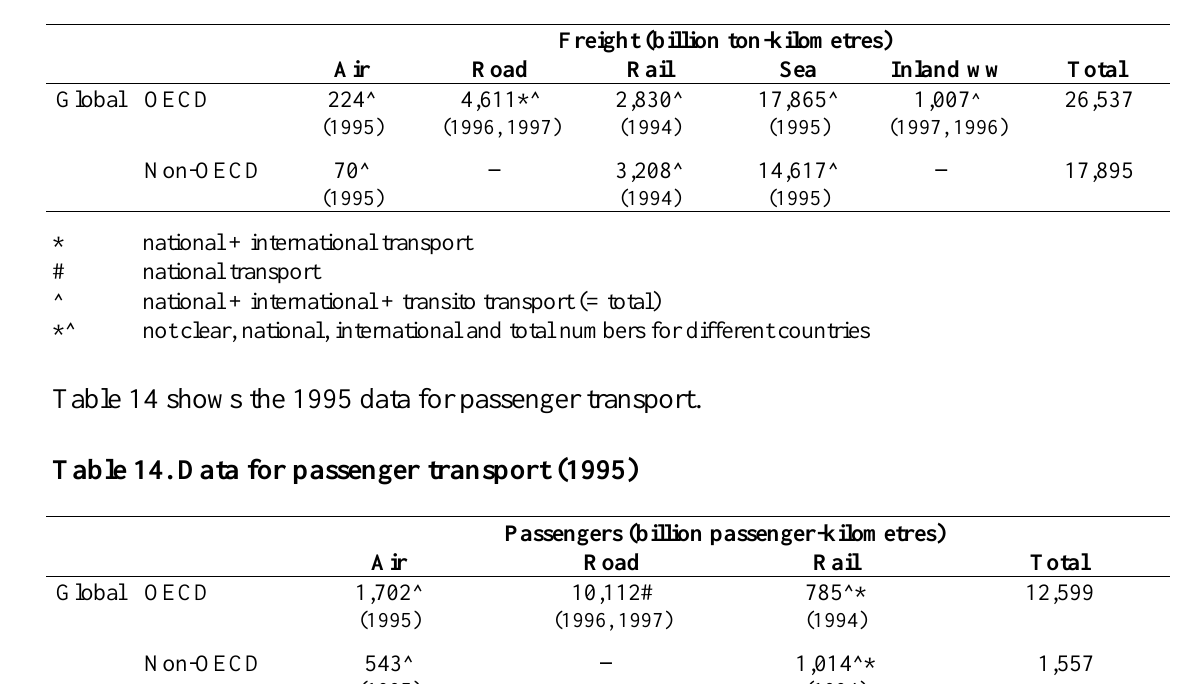
Table 13. Data for freight transport (1995)